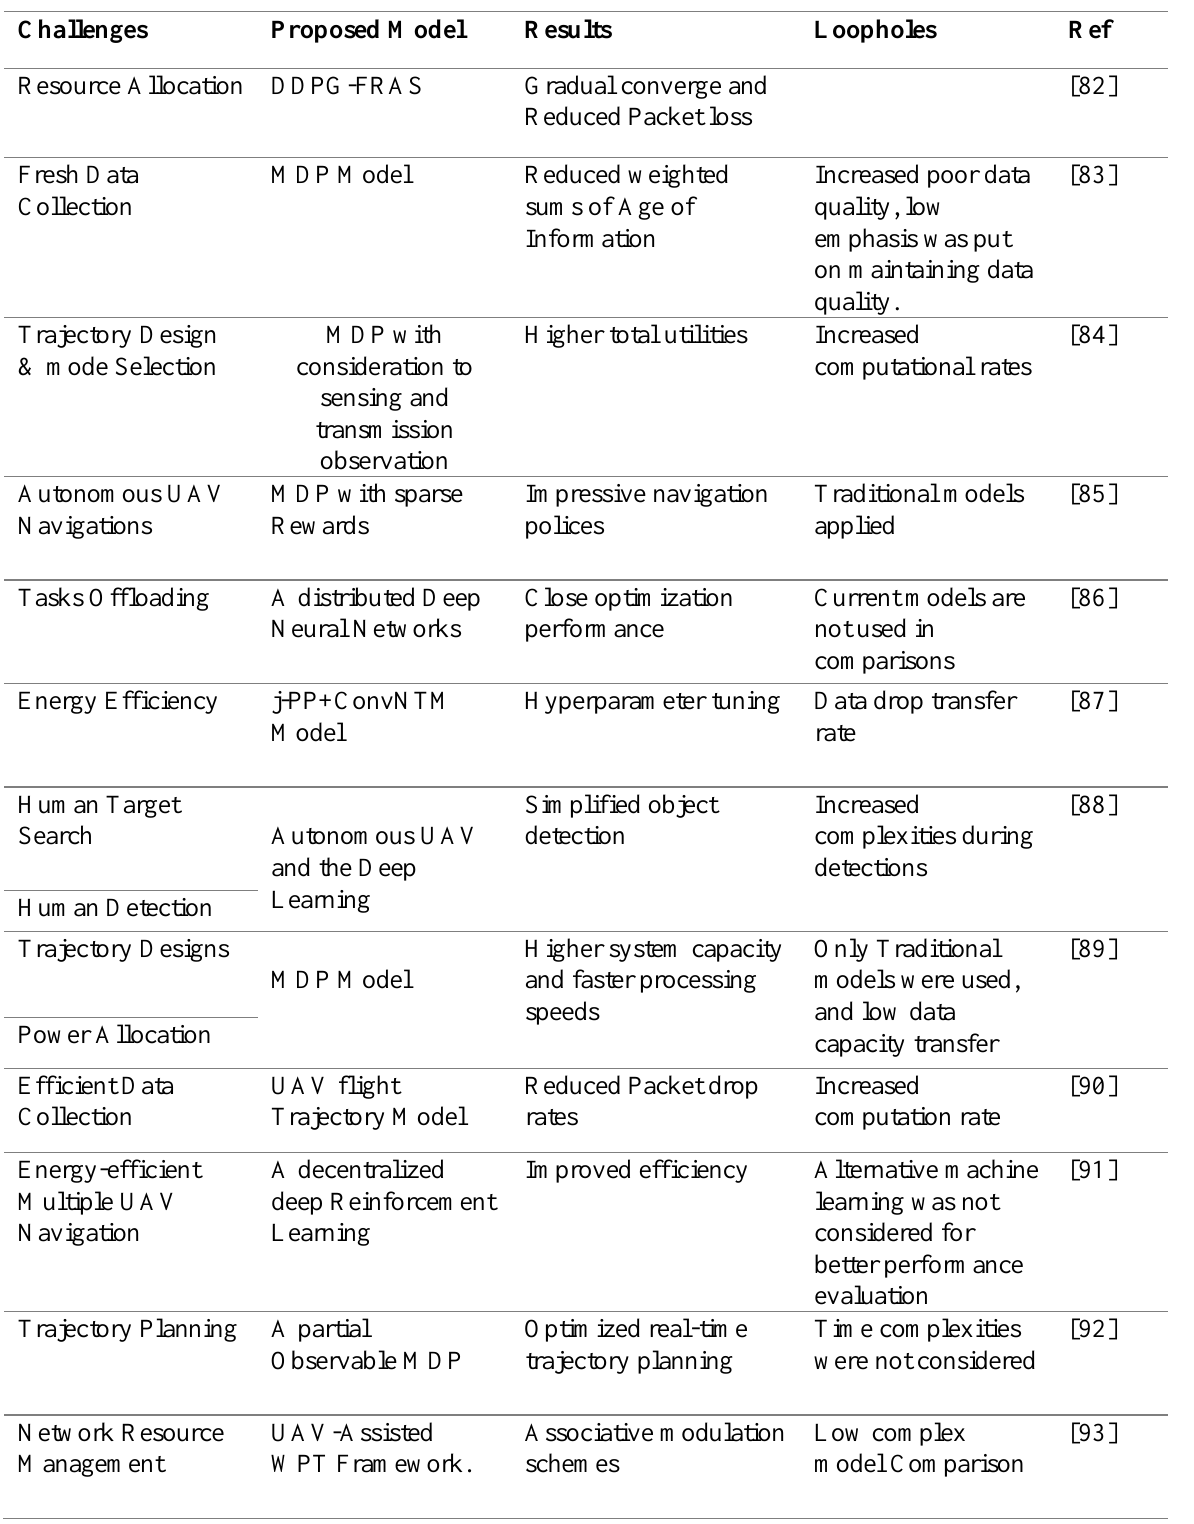
Table 3. Challenges of UAV, state-of-the-art proposed models, and loopholes